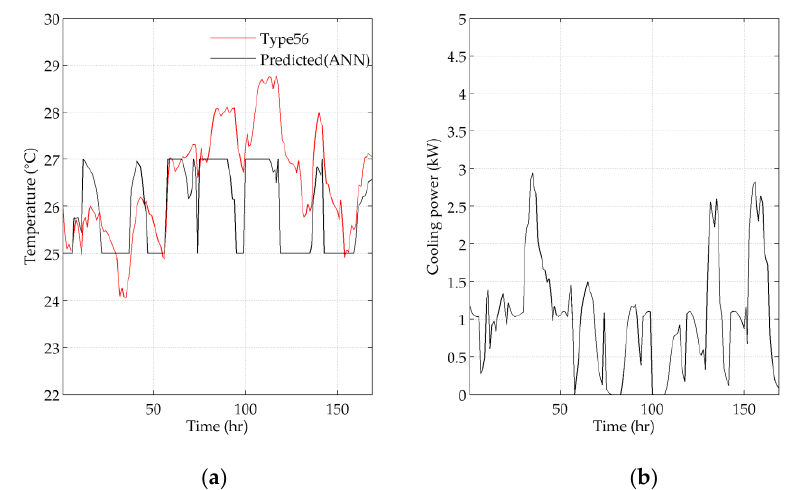
Figure 9. MPC with ANN as building prediction model: ( a ) internal air temperature, comparison between the actual Type 56 air zone temperature and ANN prediction at each timestep; ( b ) cooling power profile (control action sequences).